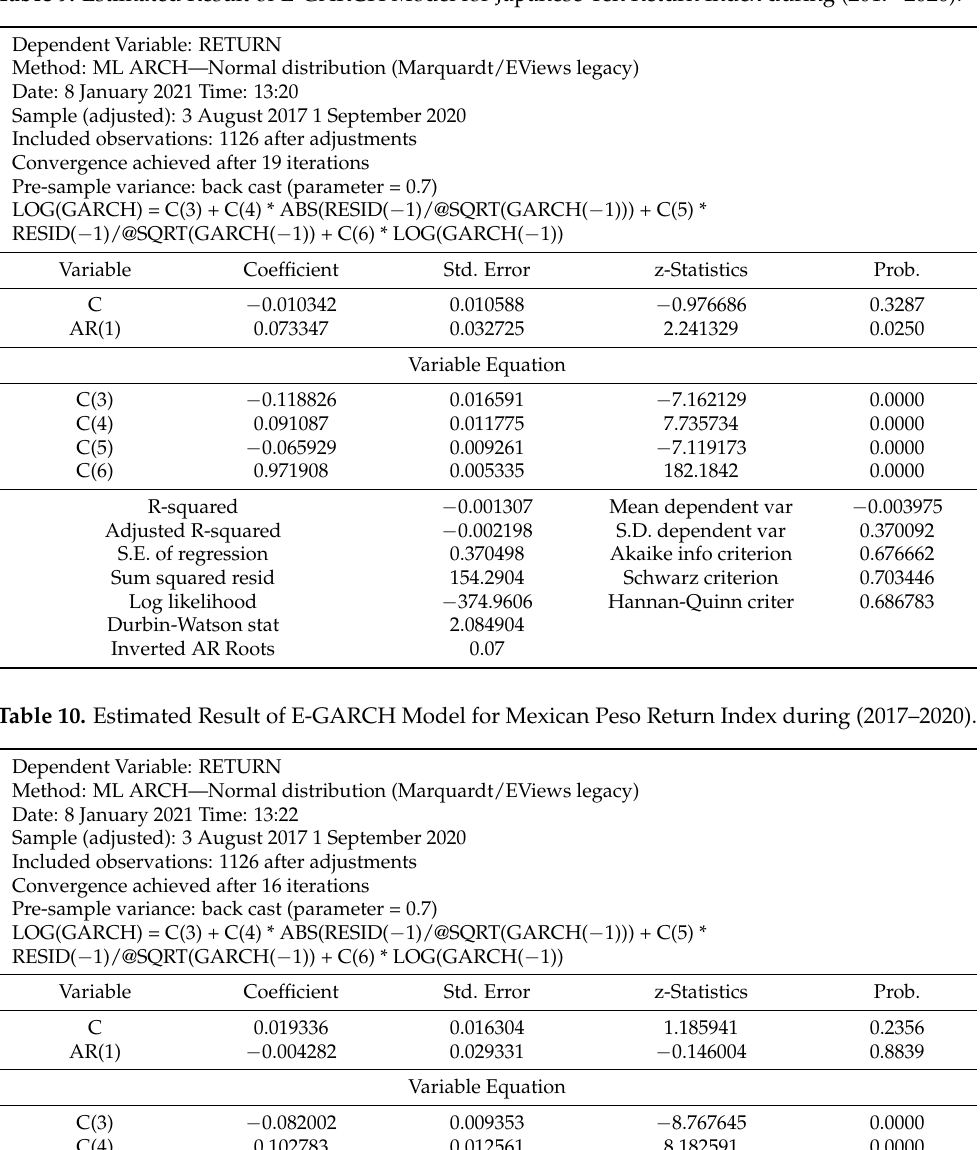
Table 9. Estimated Result of E-GARCH Model for Japanese Yen Return Index during (2017–2020).